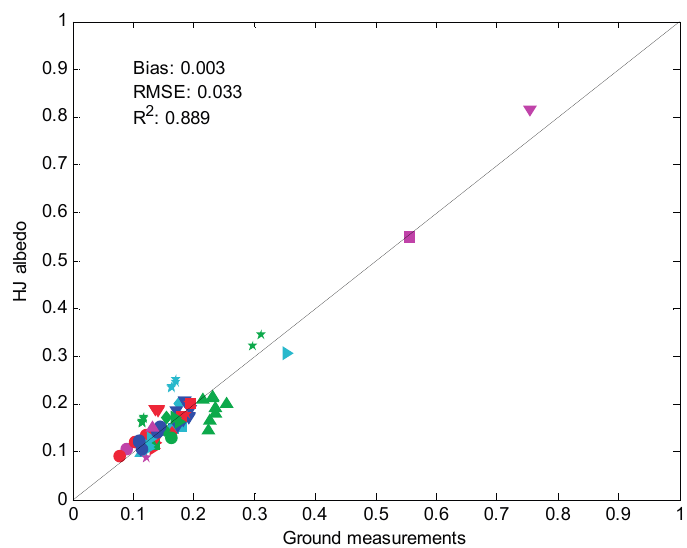
Figure 5. Comparison of HJ shortwave albedo and ground measurements at 26 AmeriFlux sites ( n = 74). Different colors and shapes represent different sites.